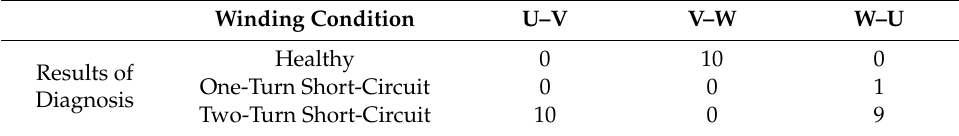
Table 8. Diagnostic results for the 2.2-kW motor 2 (two-turn short-circuit in the U phase winding).